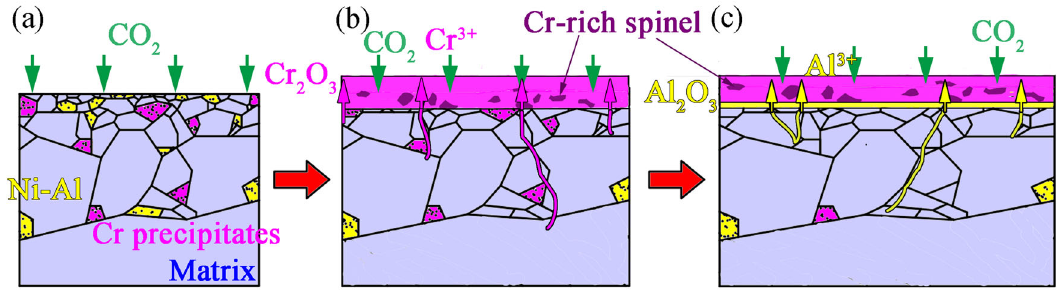
Fig. 8 Schematic corrosion process of AFA steel exposed to sCO 2 . ( a ) the original state of the materials, ( b ) the formation of Cr 2 O 3 layer, ( c ) the formation of Al 2 O 3 layer.